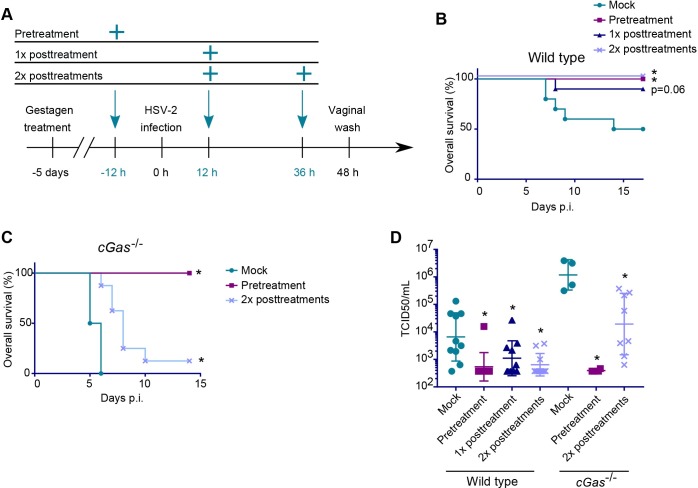
Systemic treatment with STING agonists confers protection against genital HSV2 infection.Wildtype and cGas-/- mice were treated with 2’3’-cGAM(PS)2 (Rp/Sp) (125 μg/mouse) and infected intravaginally with HSV2 (6.7×104 p.f.u.). (A) Illustration of the timeline for the treatment regimens. (B, C) Overall survival for HSV2-infected and treated wildtype (B) or cGas-/- (C) mice. n = 6–10. * = p<0,05 compared to mock. (D) HSV2 titer (TCID50) in vaginal washes collected 48 hours post infection. n = 6–10. * = p<0,05 compared to mock in the same genotype. Statistics, (B, C) Log-rank test with Holm-Bonferroni correction. (D) One-way ANOVA of log10-transformed data with Dunnett’s multiple comparisons test.